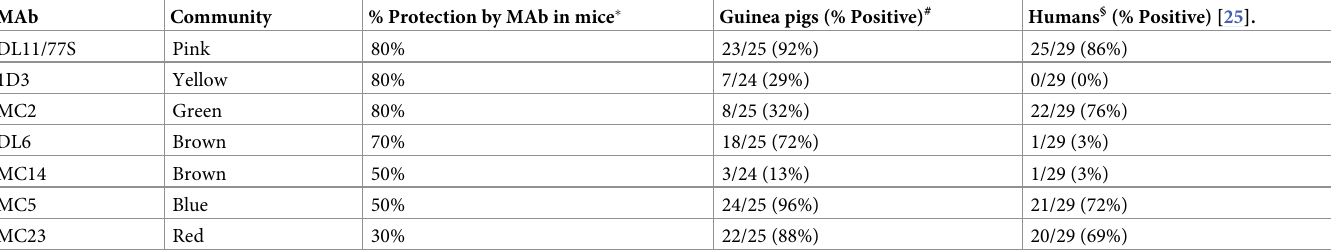
(cid:3) Data derived from Fig 5. # Guinea pigs were immunized with gD2(306t) containing 306 amino acids administered with CpG and alum. Data is derived from Fig 3. § Humans were immunized with gD2 containing 281 amino acids administered with MPL and alum. Antibody responses in guinea pigs and humans were evaluated using gD2(285t) that contains 285 gD2 amino acids [30]. All epitopes tested are contained within both gD2 immunogens.